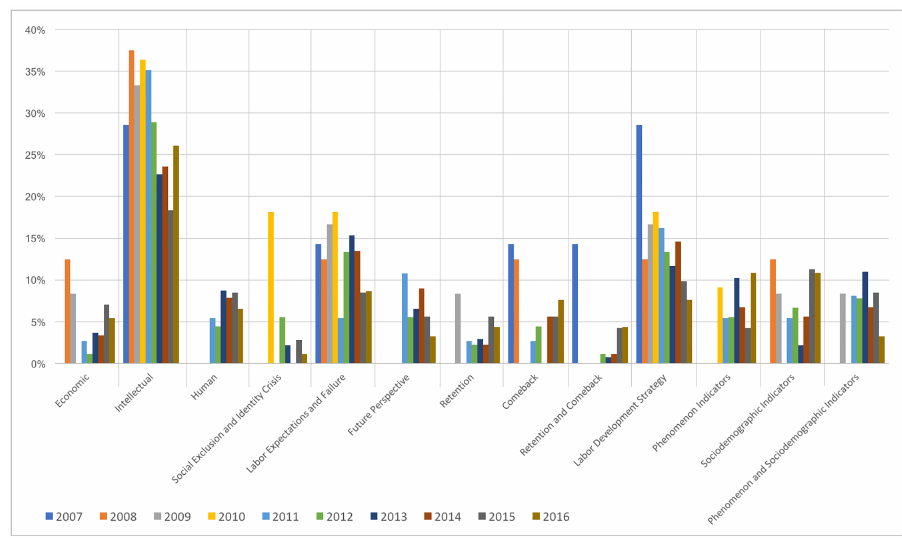
Fig 1. Spanish assessment of the phenomenon proportion by